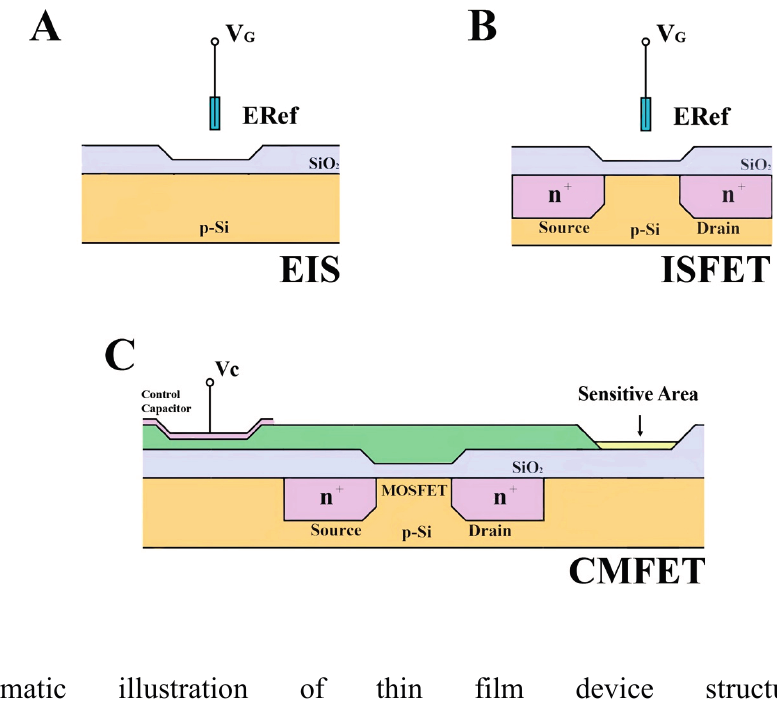
Figure 1. Schematic illustration of thin film device structures: ( A ) EIS—electrolyte-insulator-semiconductor; ( B ) ISFET- ion sensitive field effect transistor; ( C ) CMFET—charge modulated field effect transistor. ERef: reference electrode; Vg: gate voltage; Vc: Capacitor